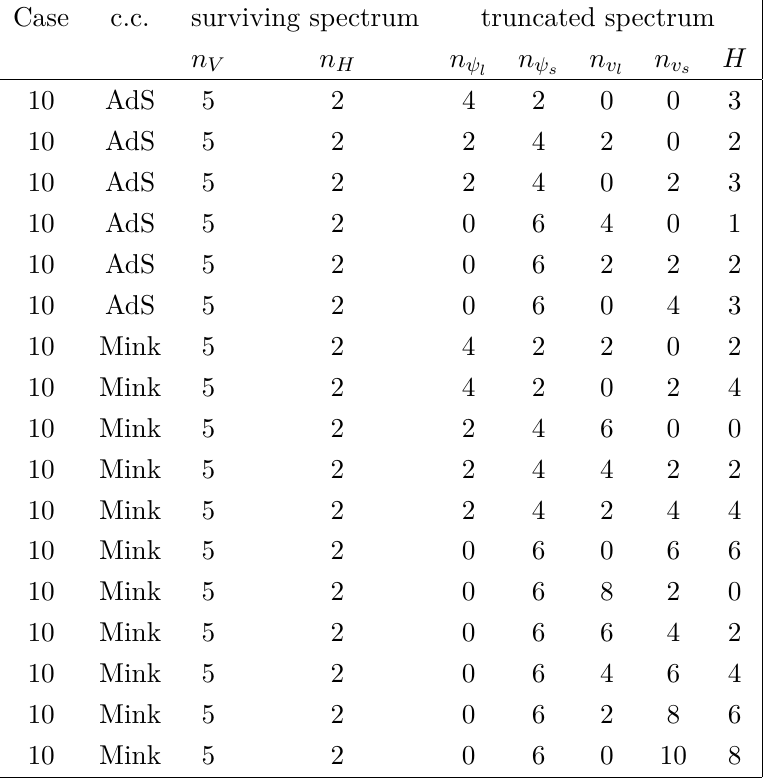
Table 8 . Supersymmetry breaking patterns and truncation of the spectrum — case 10.